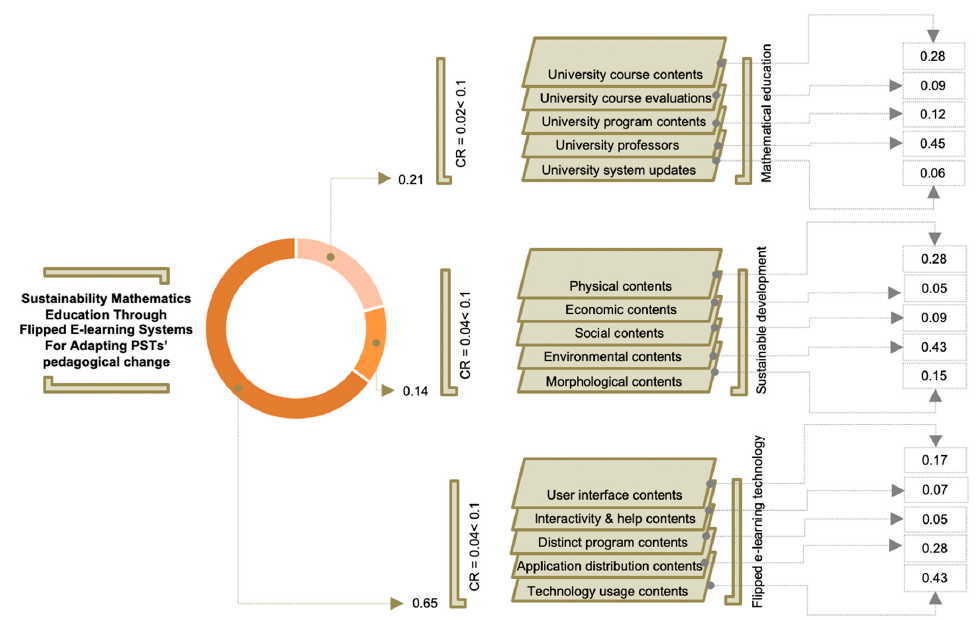
Figure 3. Results of a flipped e-learning scheme in sustainable mathematics education that adapts to PSTs’ pedagogical changes.